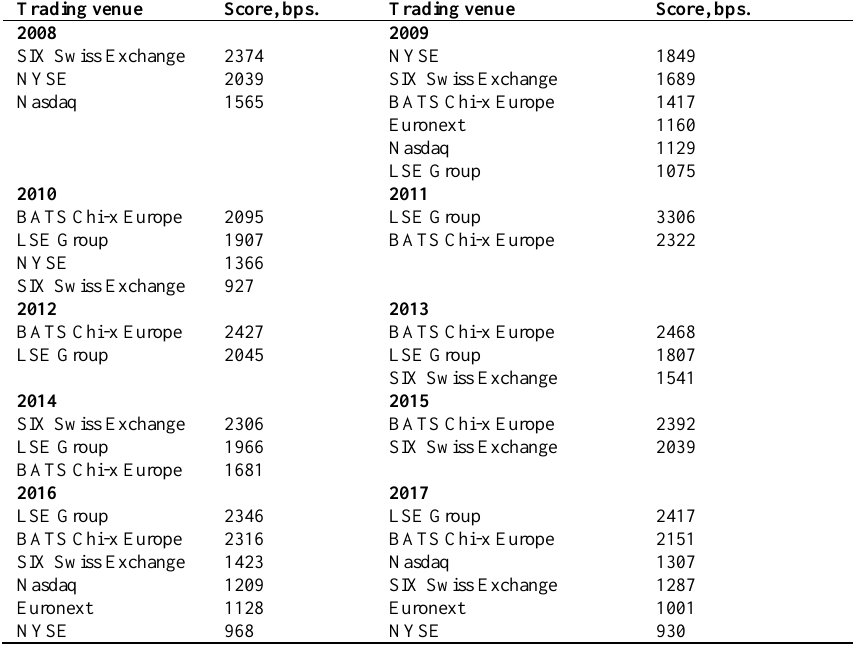
Table 6. Global systemically important trading venues for the “cross-jurisdictional activity and interconnectedness” category Trading venue